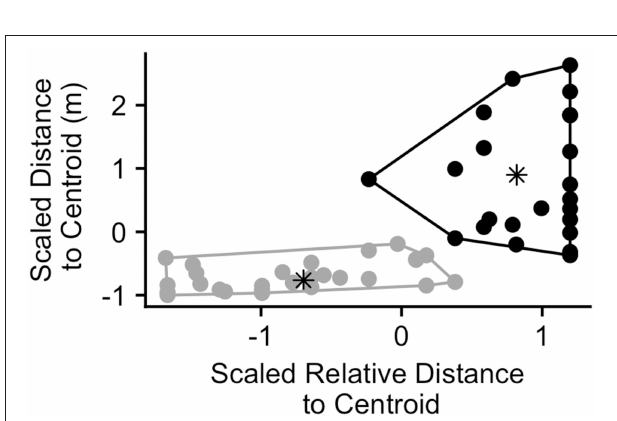
FIGURE 6 | Calling bouts plotted according to the scaled relative distance to centroid of the caller and the scaled distance to centroid of the caller (meters) at the time of the first call in the bout ( n = 50 calling bouts). Points are colored according to the cluster in which they were assigned by the cluster analysis (black = cluster 1, gray = cluster 2). The asterisks represent the center of each